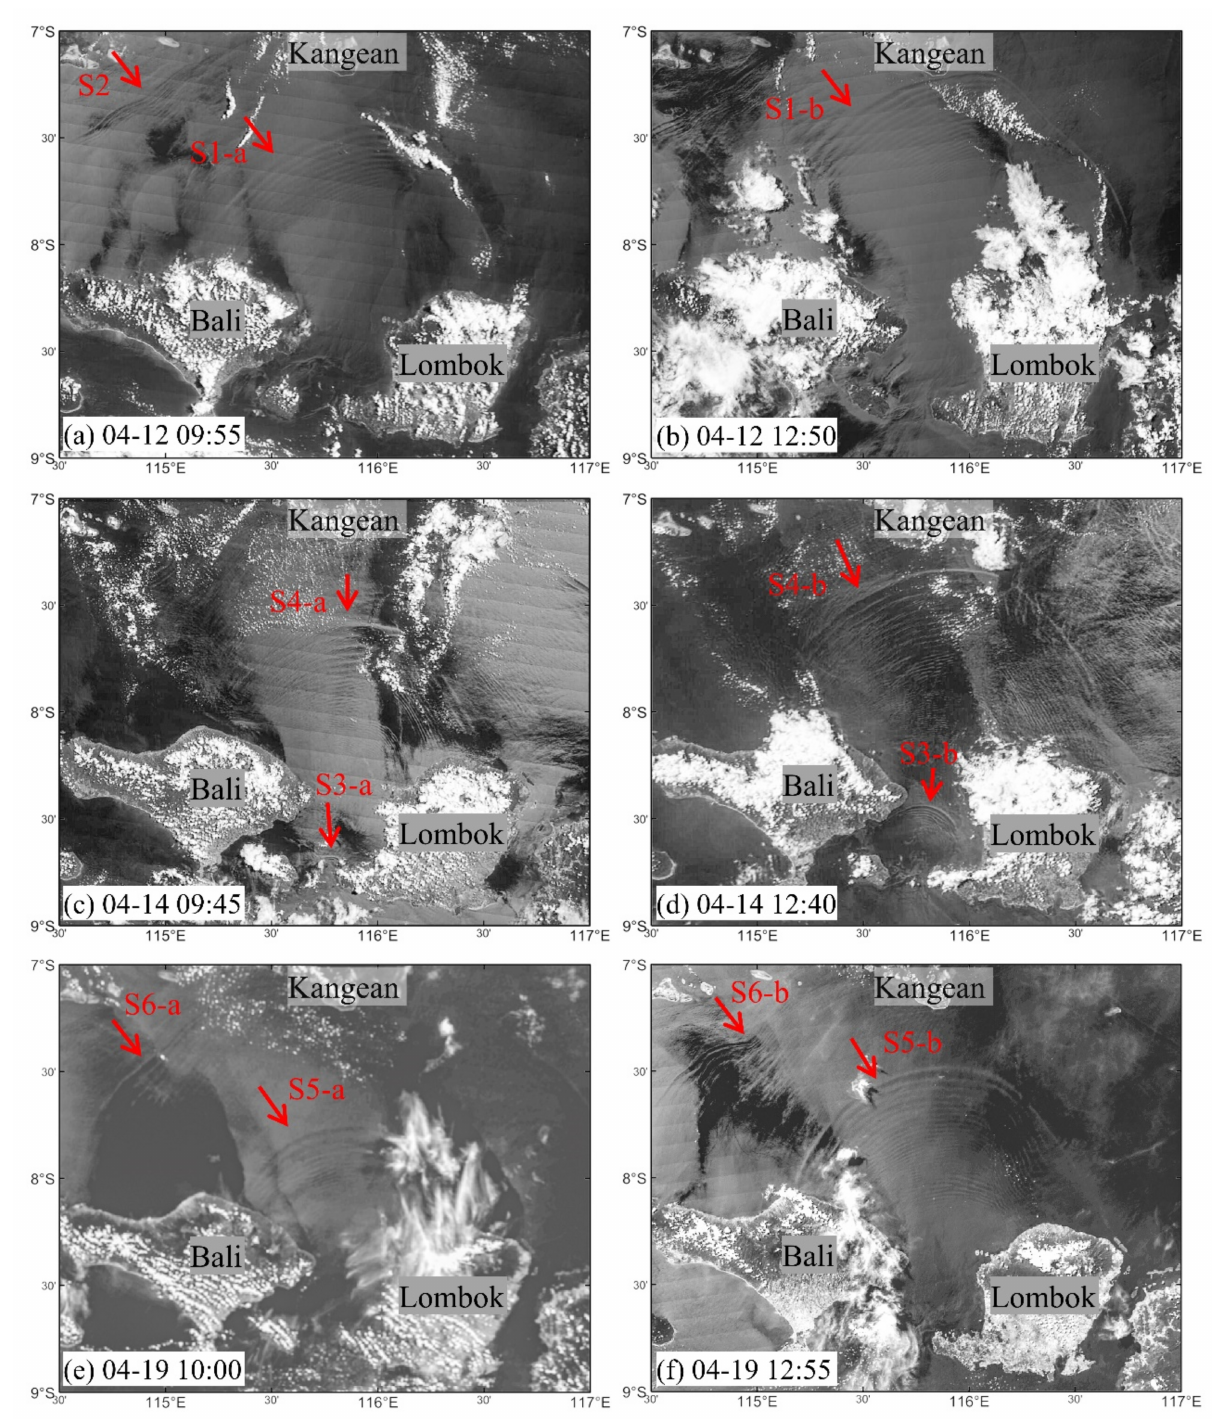
Figure 1. Optical remote sensing images over the BS acquired on 12, 14, and 19 April 2021 (local time) by